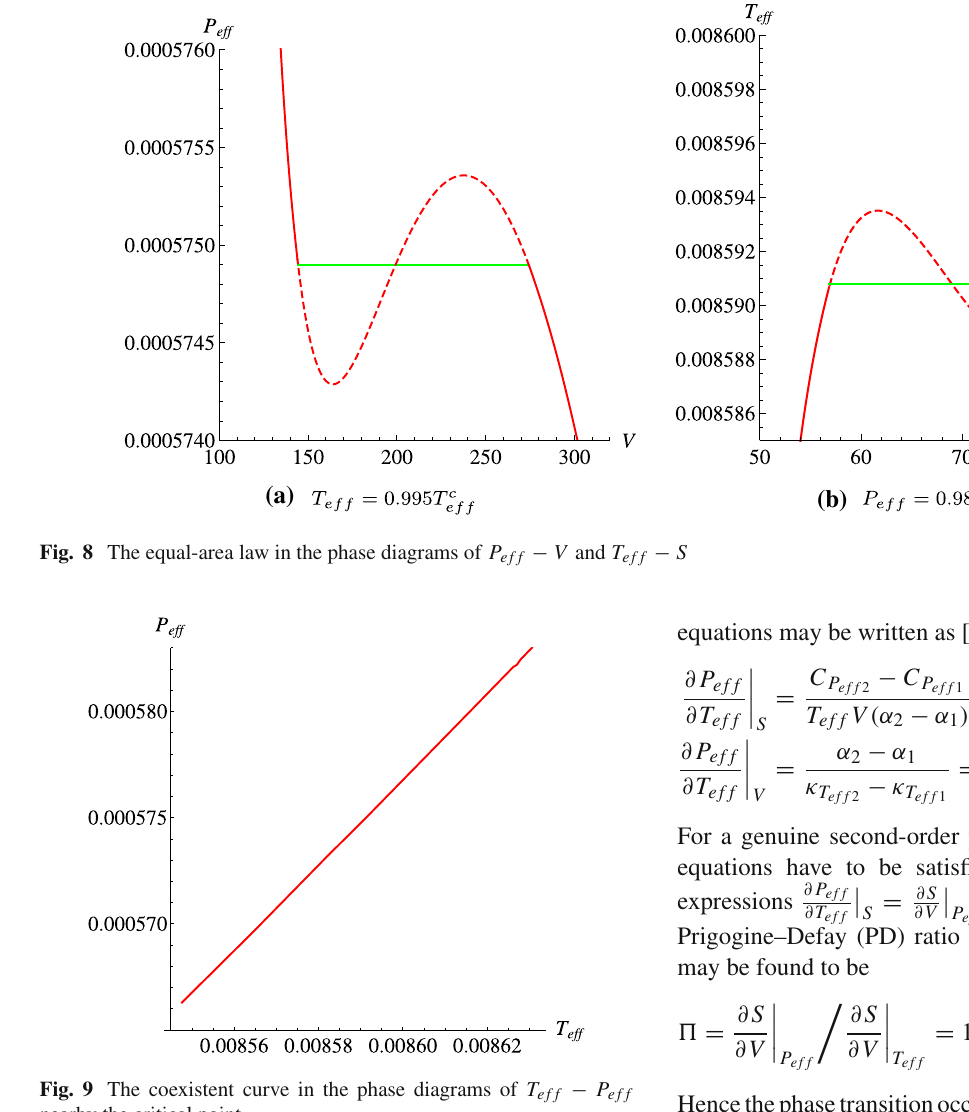
Fig. 9 The coexistent curve in the phase diagrams of T ef f − P ef f nearby the critical